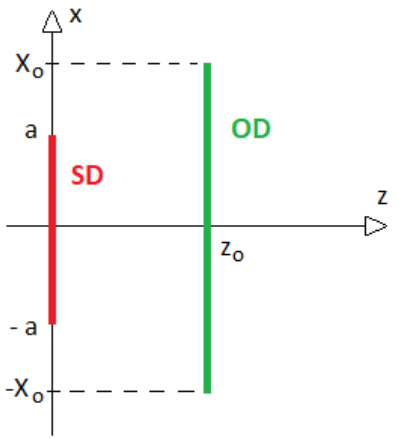
Figure 1. Configuration of the problem. The source domain ( SD ) is sketched in red, the observation domain ( OD ) in